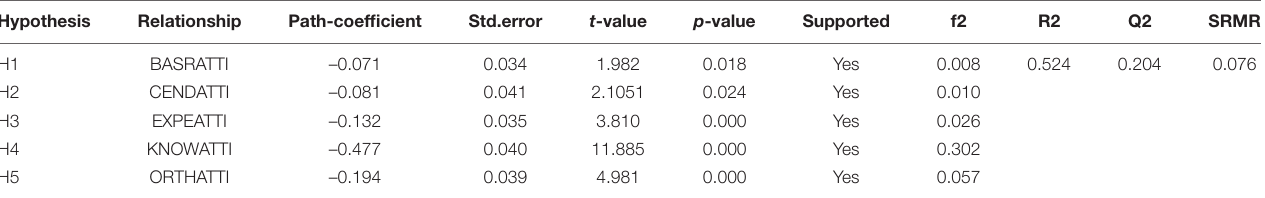
TABLE 4 | Hypotheses